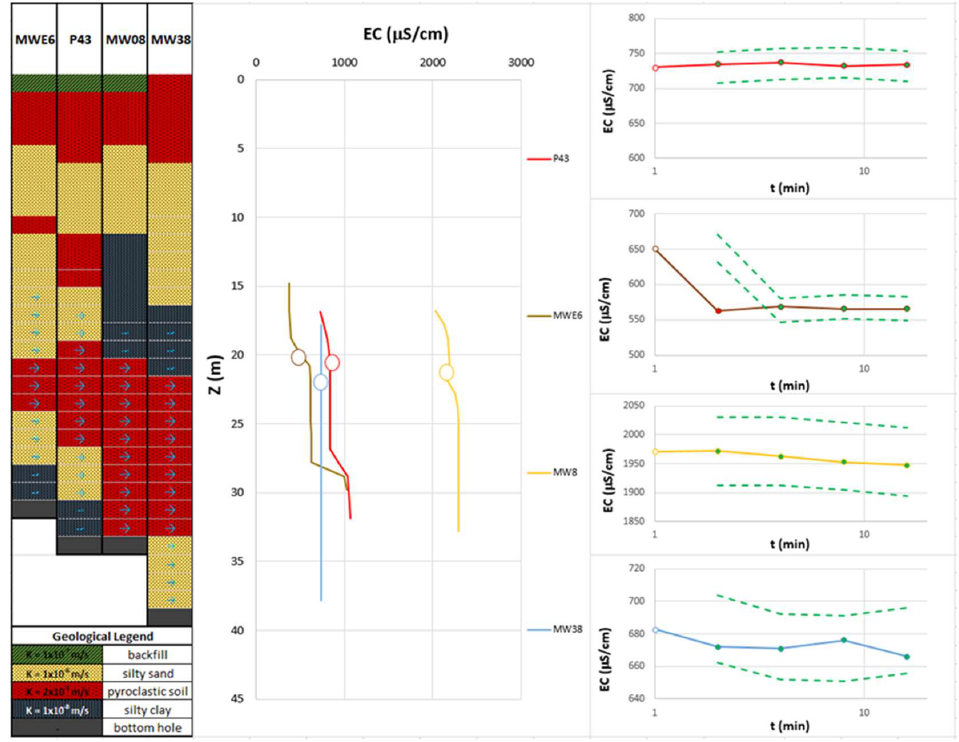
Figure 6. Layout of coupled log-purging (z-t) EC results for high-heterogeneity well types (MWE6, P43, MW8 and MW38).